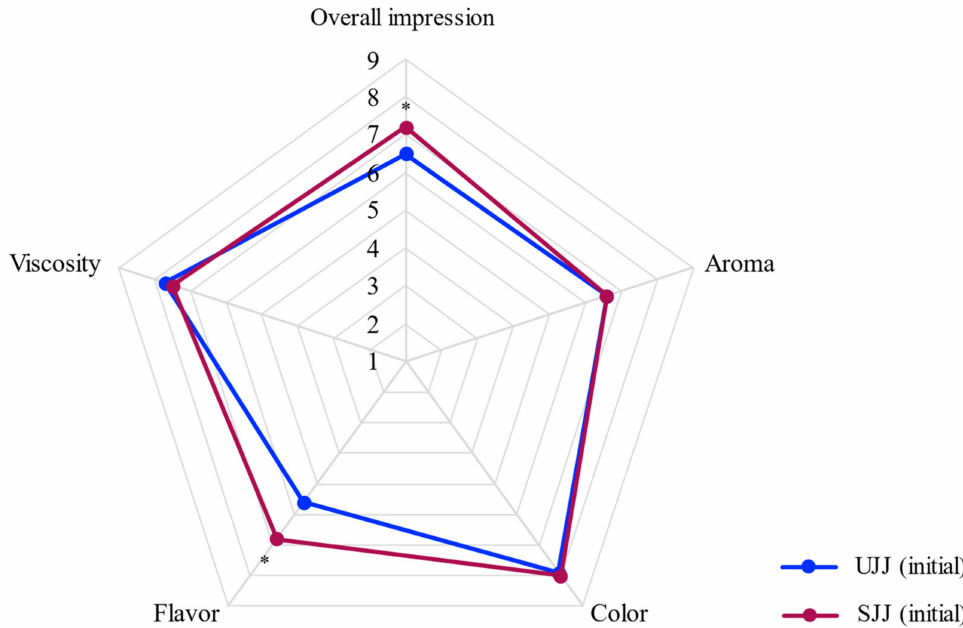
Figure 1. Average scores of descriptive sensory analysis of steam extracted jaboticaba juices. UJJ = unsweetened jaboticaba juice; SJJ = sweetened jaboticaba juice. Asterisks indicate means significantly different (Wilcoxon paired test; p < 0.05). Nine-point scale: 1 = dislike extremely; 2 = dislike very much; 3 = dislike moderately; 4 = dislike slightly; 5 = neither like nor dislike; 6 = like slightly; 7 = like moderately; 8 = like very much; 9 = like